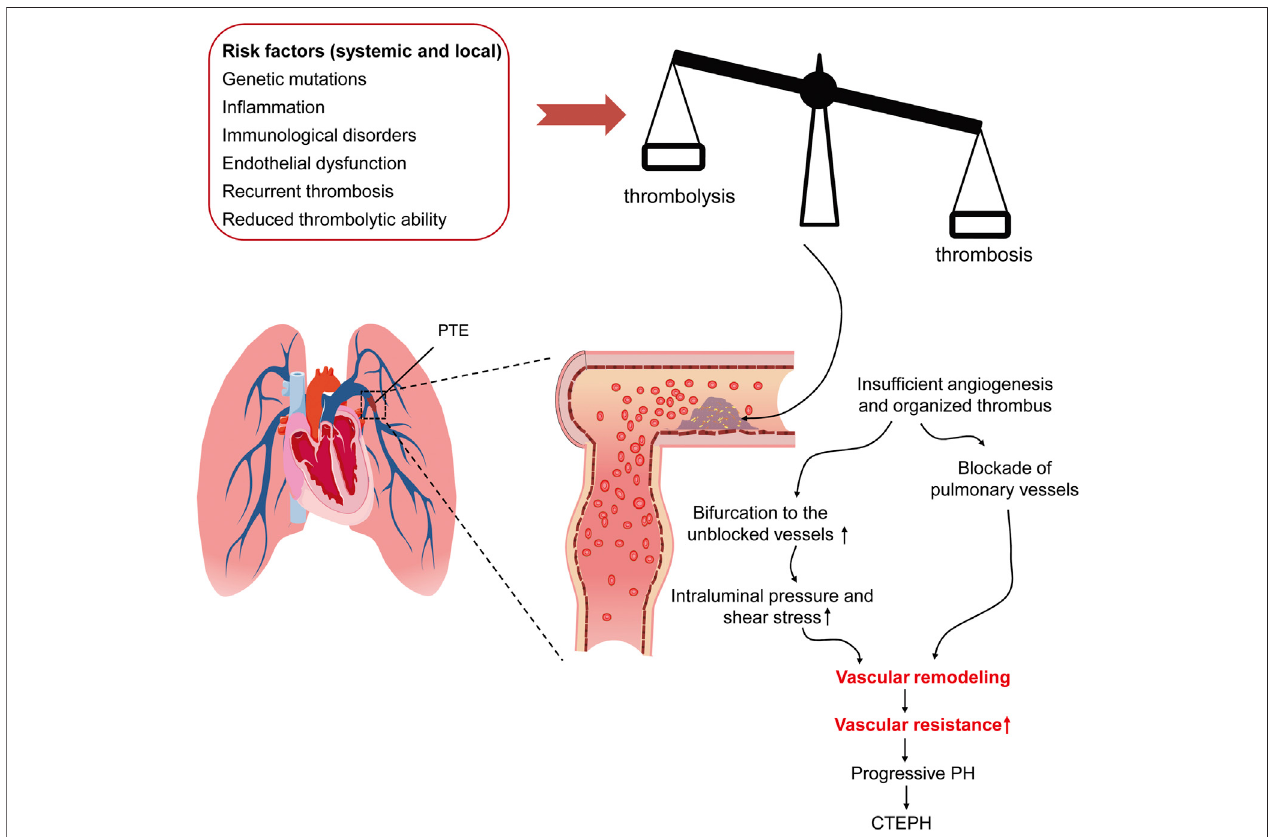
FIGURE 2 | The risk factors of and pathogenic mechanism underlying CTEPH. The pathological conditions, including genetic mutation, in fl ammation-associating endothelialdysfunction,recurrentthrombosis,andreducedthrombolyticactivity,resultintheimbalancebetweenthrombosisandthrombolysis,whichcausesinsolubility and organization of the thrombi in pulmonary arteries. As the thrombi block the pulmonary arteries, the pulmonary circulation is diverted to the unblocked ones, where intravascular pressure and shear stress is consequently elevated. Both the thrombus-mediated blockade of pulmonary arteries and the diverted blood-mediated elevation in mechanical stress lead to vascular remodeling, increased pulmonary vascular resistance, progressive PH. CTEPH, chronic thromboembolic pulmonary hypertension; PTE, pulmonary thromboembolism; PH, pulmonary hypertension.